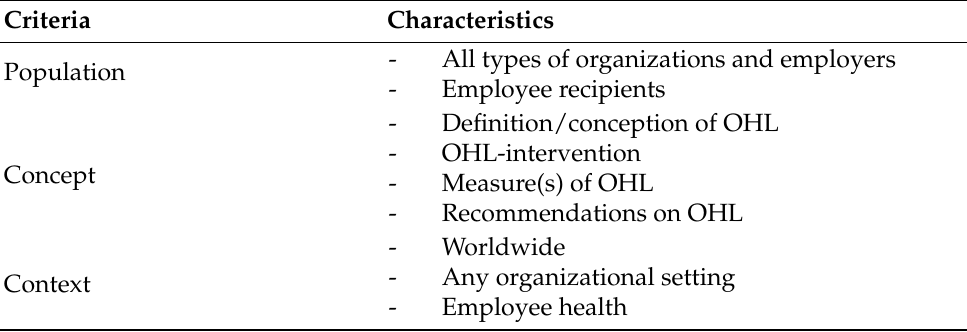
Table 1. PCC framework for identifying relevant